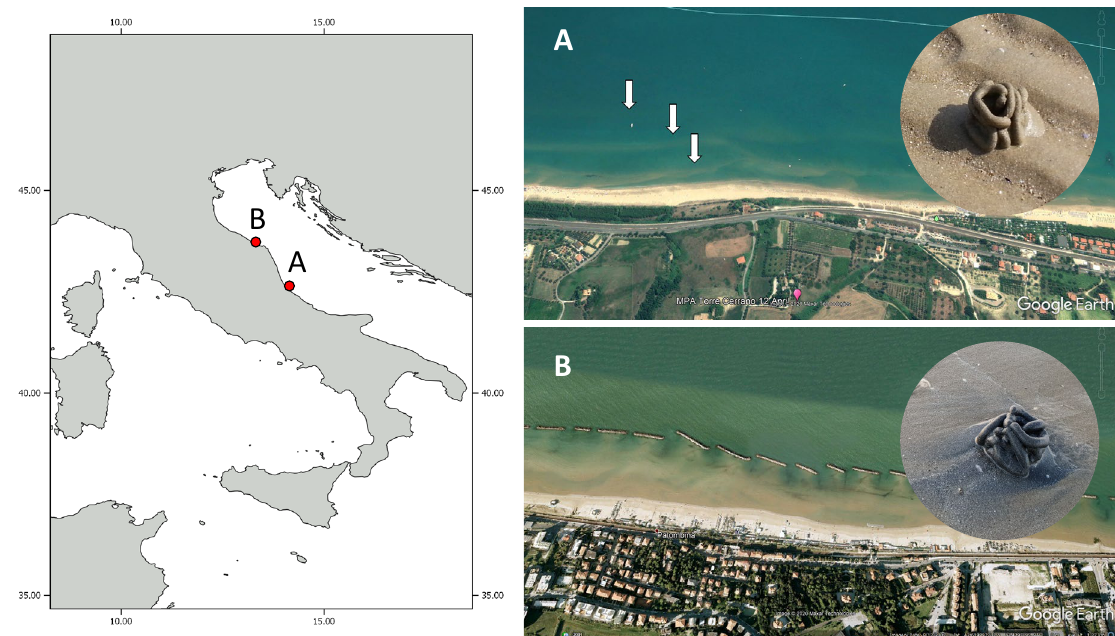
Figure 1. Study area in the north-central Adriatic Sea (Italian coast). ( A ). Torre Cerrano MPA. ( B ). Palombina. Arrows indicate sandbars; the insets show casts of burrowers containing oxic and anoxic sediments in Torre Cerrano and Palombina, respectively. Background photos from Google Earth.